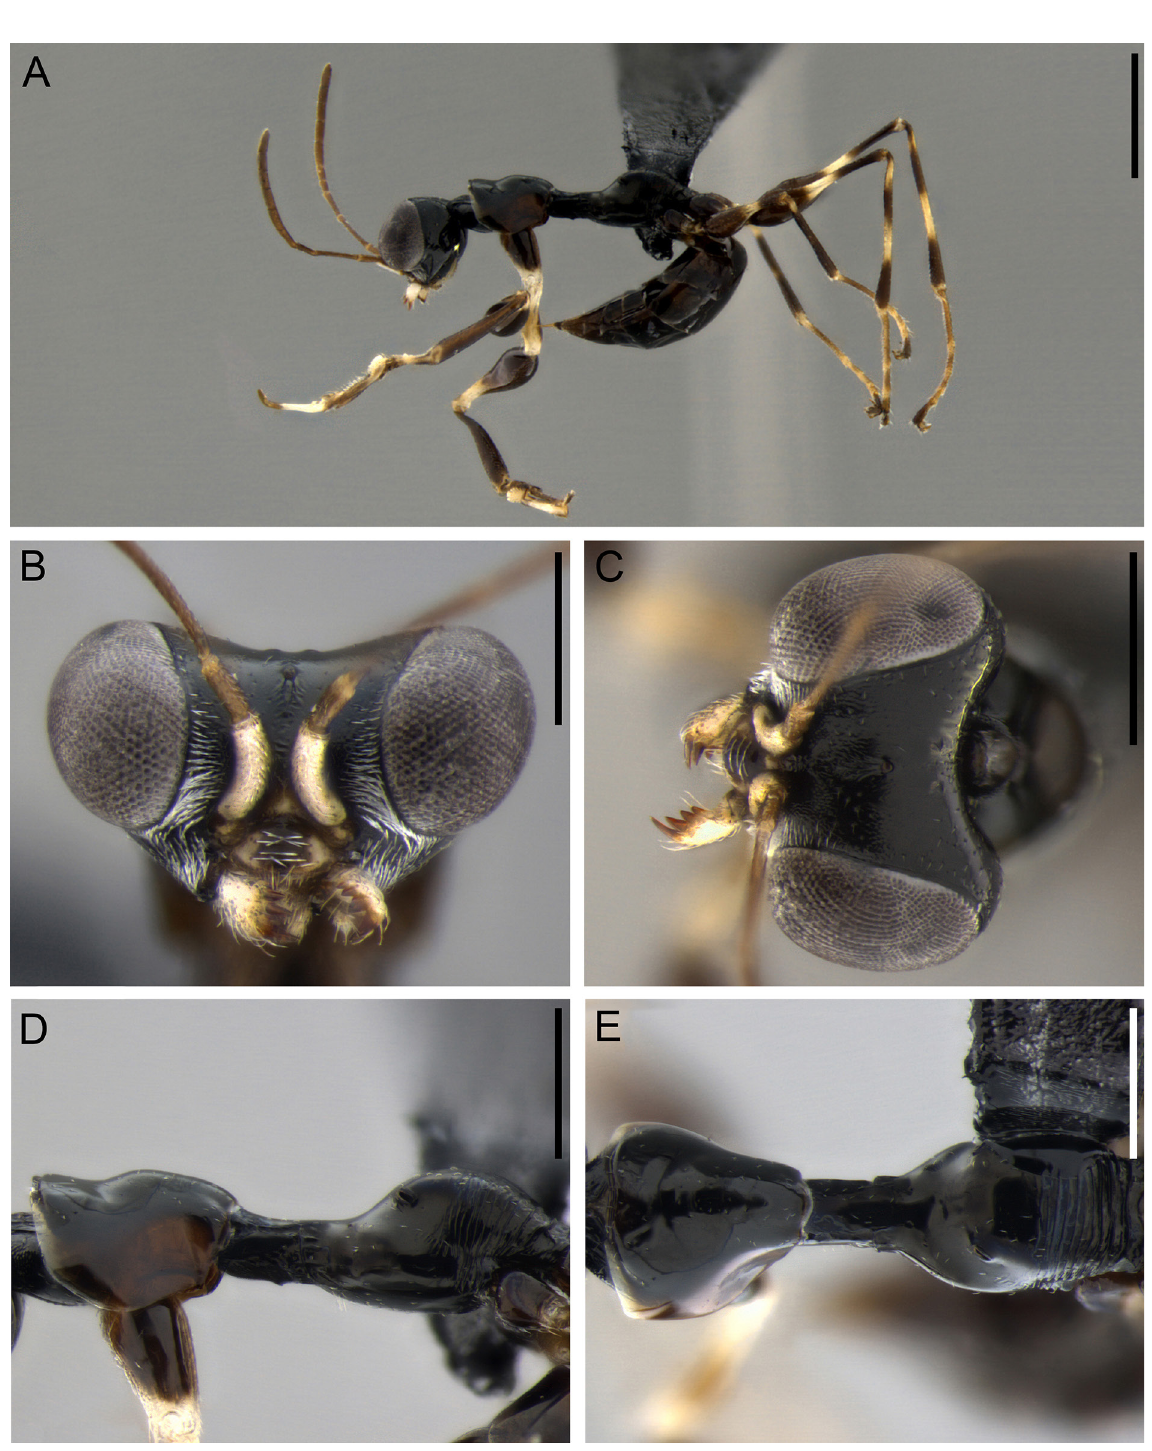
Fig. 3. Pareucamptonyx albopictus Martins sp. nov., holotype, ♀ (UFMG). A . Habitus, lateral view. B . Head, frontal view. C . Head, dorsal view. D . Mesosoma, lateral view. E . Mesosoma, dorsal view. Scale bars =